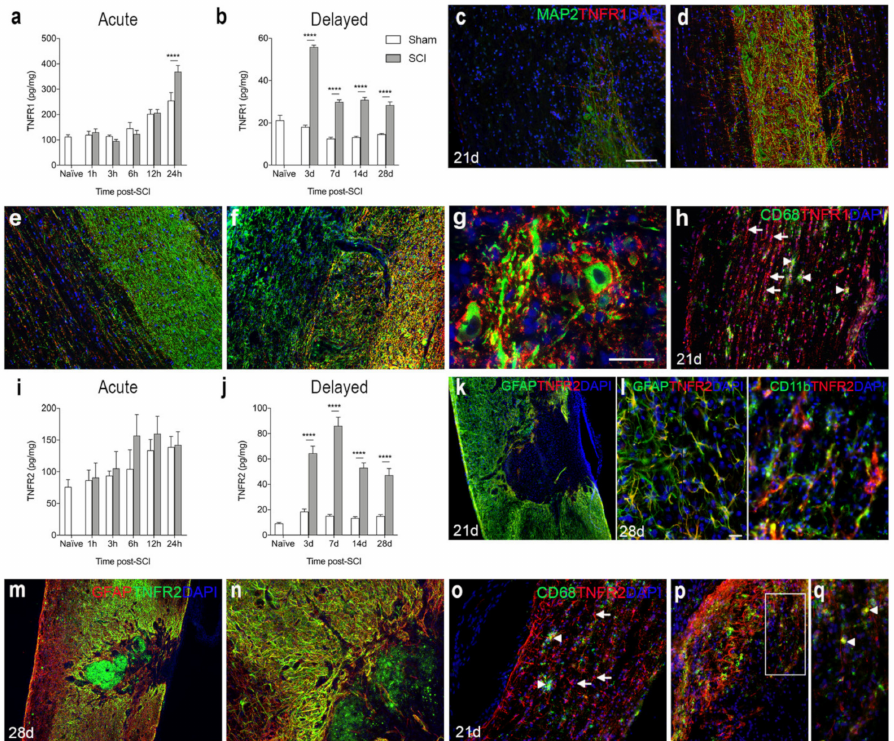
Figure 4. Spatiotemporal expression of TNF receptor 1 and 2 after SCI. ( a , b ) TNFR1 protein levels in the acute ( a ) and delayed ( b ) phases after SCI. Significant indications represent comparisons to sham mice in the acute phase ( a , Interaction: F 5,48 = 4.52, p = 0.002; Time: F 5,48 = 45.74, p < 0.0001; SCI: F 1,48 = 2.19, p = 0.15) and delayed phase ( b , Interaction: F 4,40 = 49.51, p < 0.0001; Time: F 4,40 = 52.17, p < 0.0001; SCI: F 1,40 = 406.5, p < 0.0001) after SCI. ( c – g ) Immunofluorescent double labelling for TNFR1 (red) and neuronal MAP2 (green) within the lesion site ( c ), peri-lesion area ( d , f , g ), as well as distant from the lesion site ( e ) at 21 ( c – e ) and 28 ( f , g ) days after SCI. ( h ) Immunofluorescent double labelling for TNFR1 + (red) and CD68 + (green) cells 21 days after SCI. ( i , j ) TNFR2 protein levels in the acute phase ( i , Interaction: F 5,47 = 0.42, p = 0.83; Time: F 5,47 = 3.89, p < 0.005; SCI: F 1,47 = 1.75, p = 0.19) and delayed phase ( j , Interaction: F 4,40 = 25.04, p < 0.0001; Time: F 4,40 = 36.07, p < 0.0001; SCI: F 1,40 = 2702.8, p < 0.0001) after SCI. ( k – n ) Immunofluorescent double labelling for TNFR2 (red: k , l and green: ( m , n ) and GFAP + astrocytes (green: ( k , l ) and red: ( m , n )) and CD11b + microglia/macrophages (green: ( l )) at 21 ( k ) and 28 ( l – n ) days after SCI. ( o – q ) Immunofluorescent double labeling of TNFR2 + cells (arrows in ( o )) and CD68 + microglia/macrophages (arrow heads in ( o )). ( p ) Only a few CD68 + cells co-expressed TNFR2. ( q ) represents a high magnification image of the area squared in ( p ), demonstrating TNFR2 + CD68 + cells located in the peri-lesion areas 21 days after SCI (arrow heads in ( q )). DAPI was used as a nuclear marker. Scale bars: ( k , m ) = 100 µ m, ( c – f , h , n – p ) = 40 µ m, and ( g , l , q ) = 20 µ m. Results are expressed as mean ± SEM, n = 5/group, **** p < 0.0001. GFAP, glial fibrillary acidic protein; MAP2, microtubule associated protein 2; TNFR, tumor necrosis factor